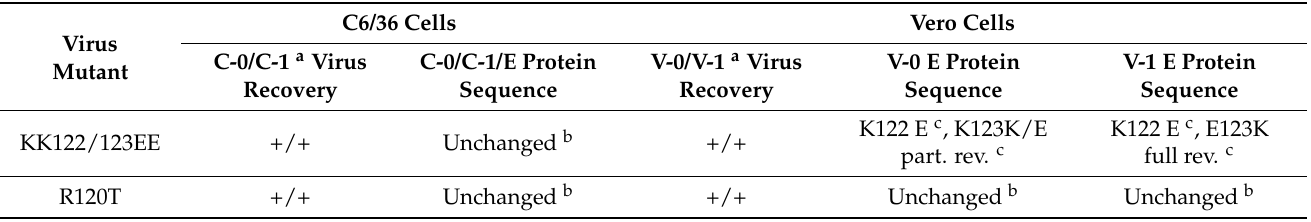
Table 3. Transfection and infection by 30P-NBX E protein DII mutants in C6/36 or Vero